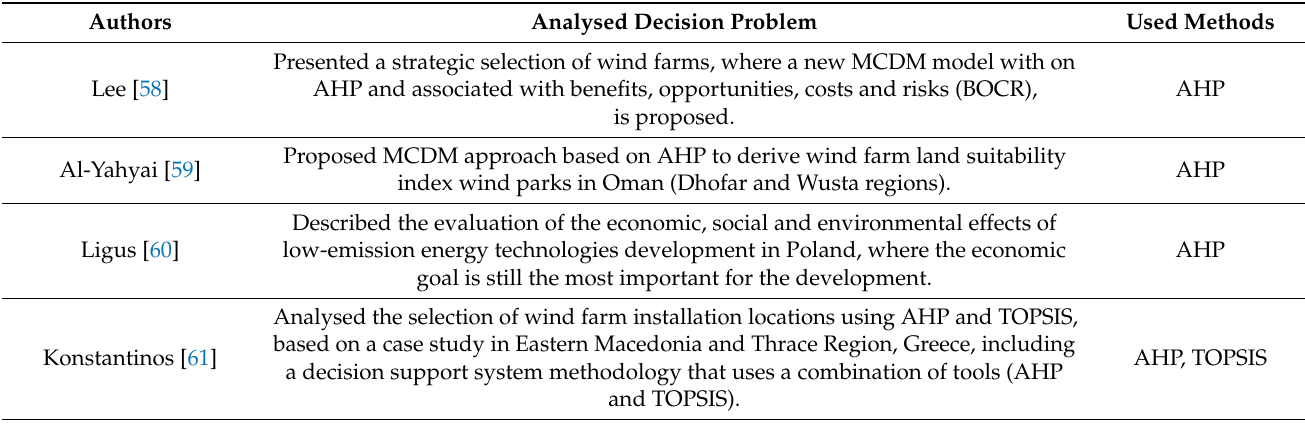
Table 1. Multi-criteria decision analysis methods used in previous studies.